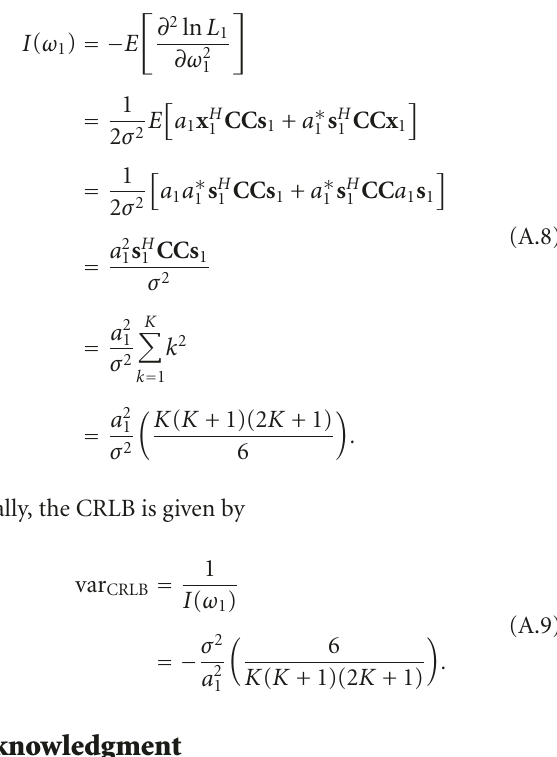
Substituting (A.7) into the Fisher information function